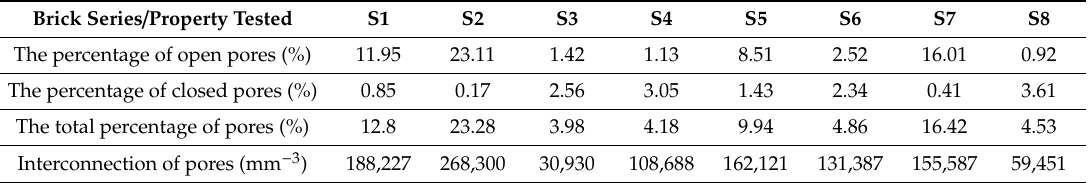
Table 4. Summarized results of the methods applied to test brick resistance to freeze-thaw cycles.